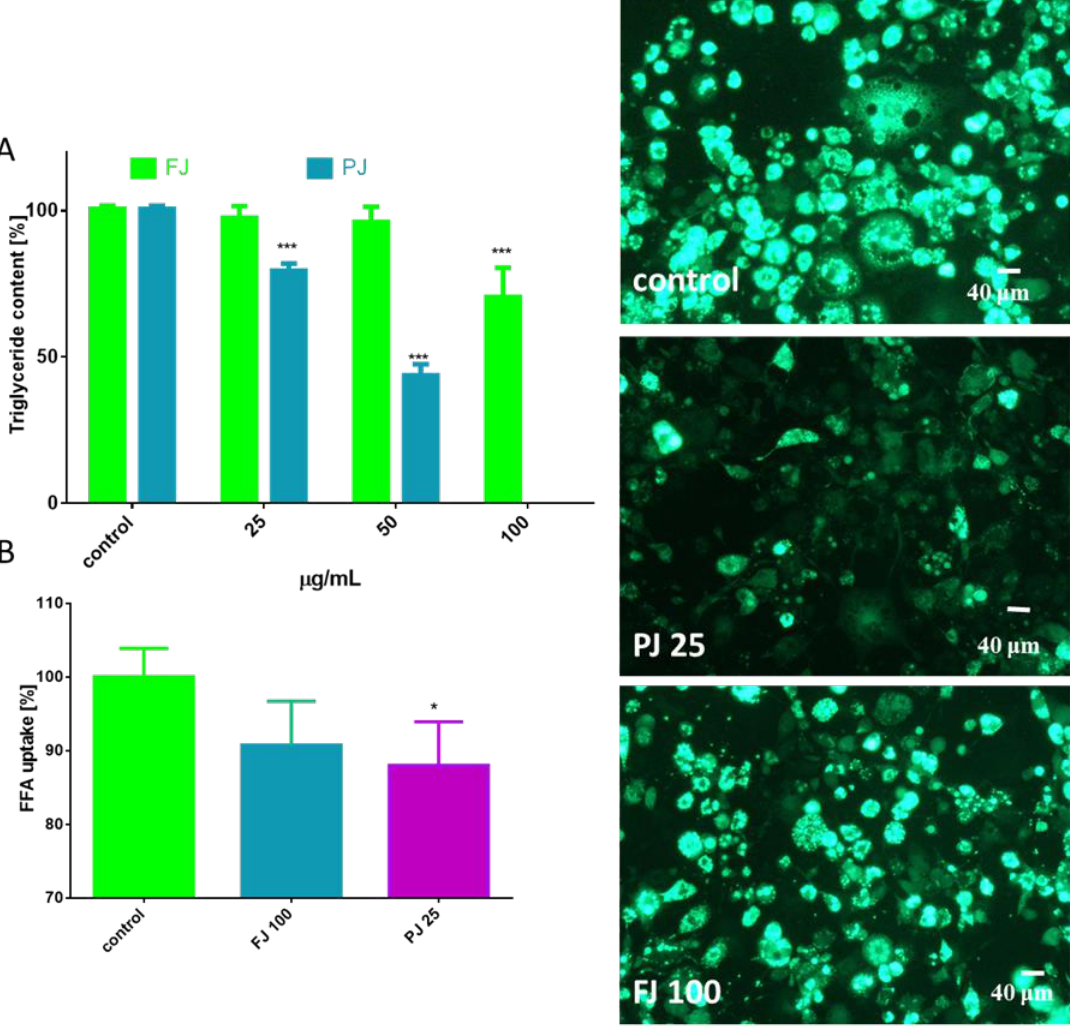
Figure 5. The influence V. opulus extracts on the triglyceride level ( A ) and fatty acid analog TF2-C12 uptake measured in 3T3L1 cells on the 7 th day of differentiation ( B ); control cells were not exposed to any compound; values are means ± standard deviations from at least three independent experiments, n ≥ 9; statistical significance was calculated versus control cells * p ≤ 0.05, *** p ≤ 0.001. Cellular uptake of FFA-C12 analogue visualized under a fluorescent microscope (400 × magnification) ( C ).